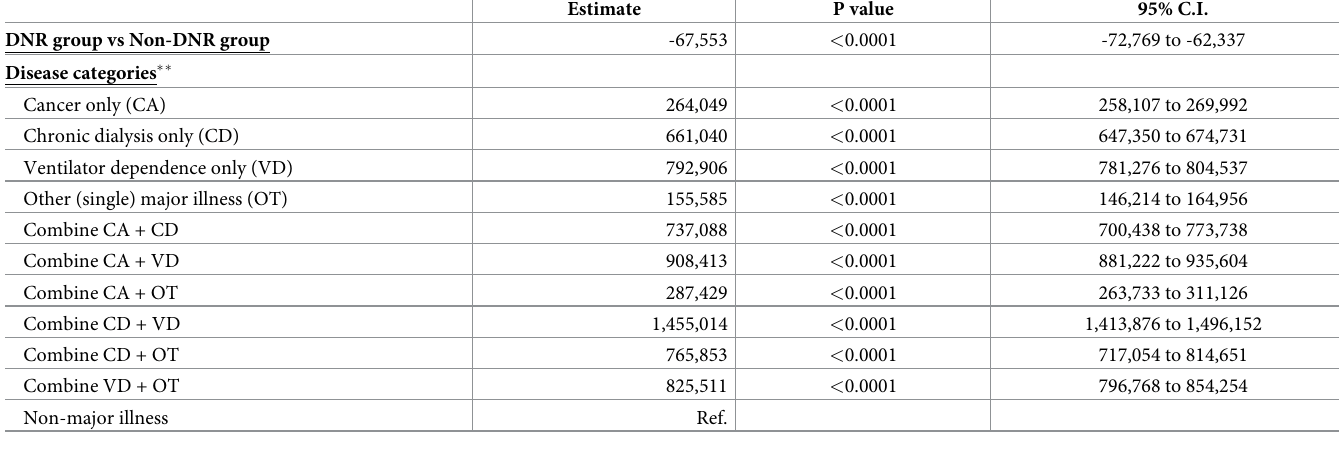
Table 3. Adjusted � cost differences between DNR and Non-DNR groups. Estimate P value 95%